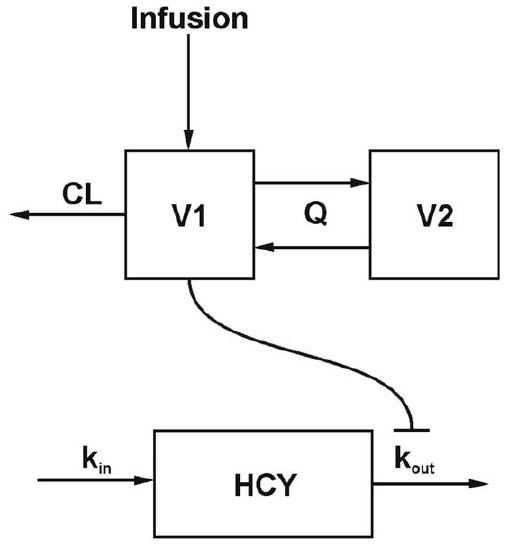
Figure 2. Scheme of the PK/PD model (CL= total body clearance; Q=intercompartmental clearance; V1=volume of the central compartment; V2= volume of the peripheral compartment; HCY=homocysteine; k in =HCY formation rate constant; k out = HCY elimination rate constant).